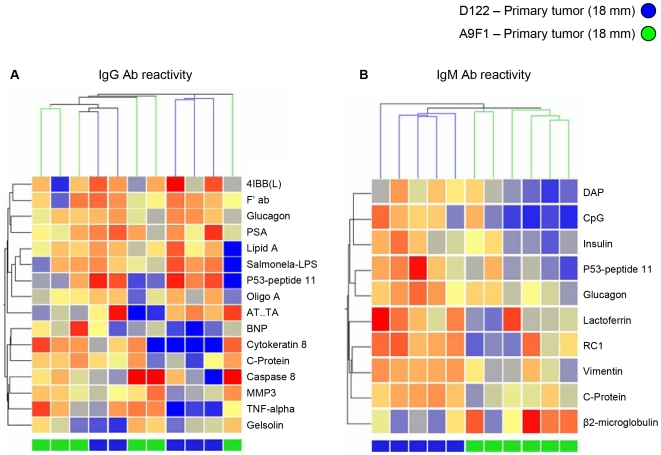
Clustering of antibody reactivities discriminates between mice bearing different tumor clones.Hierarchical clustering of IgG (A) and IgM (B) antibody reactivities in mice bearing 18 mm3 primary of the A9F1 and D122 clones based on separating antigens that were chosen by the Wilcoxon rank-sum test in the array (see supplementary Table S3I, Supplementary Data). A color code denoting D122 (blue) and A9F1 (green) samples is shown at the top and bottom. The color scale shows the relative degree of antibody binding from low (dark blue) to high (dark red). The mice bearing different clones are separated by their IgM reactivities.